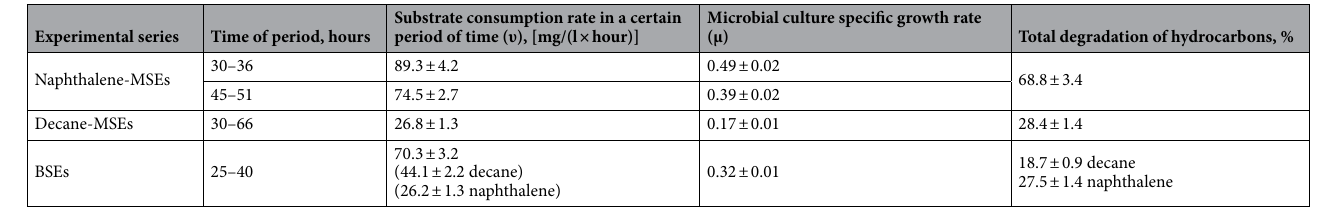
Table 2. Physiological parameters of strain growth in MSEs and